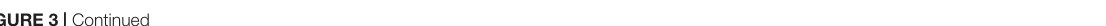
Figure 2D legend. Fixed ECs were incubated in primary antibodies against NRP2 and ITGA5. Images were captured using a Zeiss AxioImager M2 microscope at 63x magnification. Arrows indicate co-localization of NRP2 and ITGA5. (D) : siRNA-transfected ECs were prepared as described in Figure 2D legend, however, ECs were allowed to adhere overnight prior to fixation. ECs were incubated in primary antibody against ITGA5. (E) siRNA-transfected ECs were prepared as described in (D) , however, fixed cells were incubated in ITGA5 primary antibody and phalloidin-364. Arrows indicate localization of ITGA5 with actin filaments. Image panels shown in (C–E) are representative of n ≥ 10 cells per